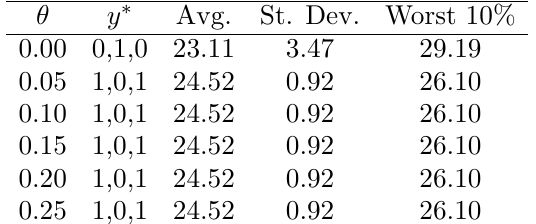
Figure 4. Locations of the cus- tomers (circles) and potential facili- ties (diamonds).